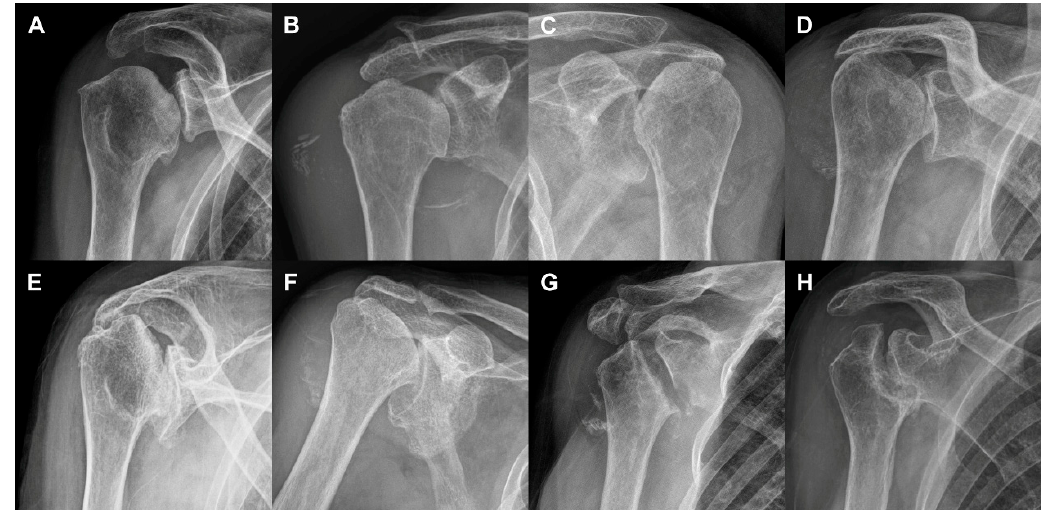
Figure 2. Incidence of radiographic findings.